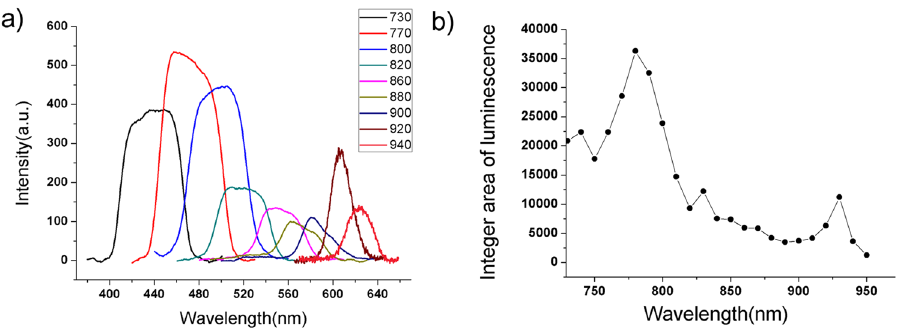
Figure 6. ( a ) Upconversion photoluminescence spectra of an aqueous solution of N-dots at various excitation wavelengths and ( b ) Integration of the area under the photoluminescence peaks at the excitation wavelengths of 730–950 nm in ( a